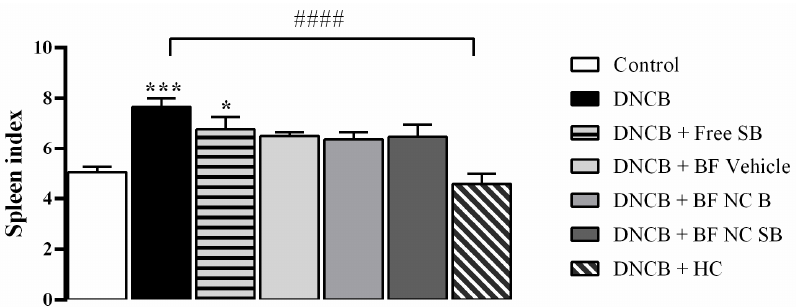
Figure 7. Effect of the different treatments on the spleen index. This parameter was assessed on day 31 of the experimental protocol. Each column represents the mean ± SEM of 7 mice per group. (***) p < 0.001 and (*) p < 0.05 compared with the control group, (####) p < 0.0001 compared with the DNCB group (One-way ANOVA followed by the Tukey’s test).